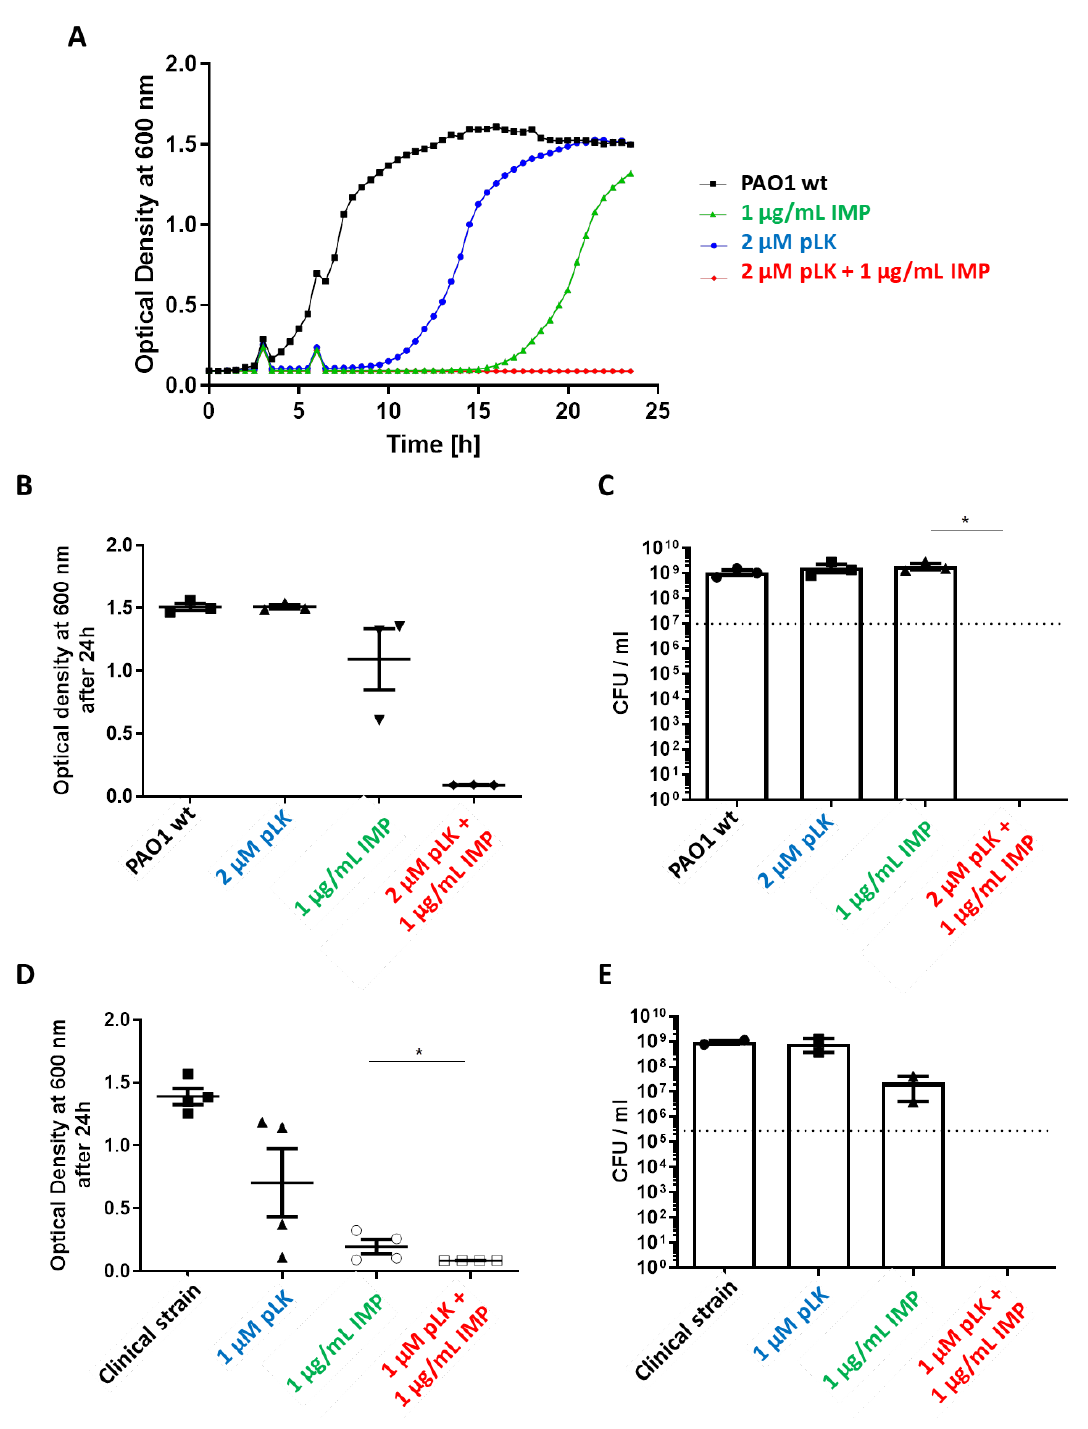
Figure 2. In vitro effect of the pLK and imipenem association against the reference (PAO1) and imipenem-sensitive P. aeruginosa strains. PAO1 (1 × 10 7 /mL in exponential phase) and an imipenem- sensitive clinical P. aeruginosa (1 × 10 5 /mL in exponential phase) strain were incubated at 37 ◦ C in Mueller–Hinton medium in the presence or absence of 2 uM ( A – C ) or 1 uM ( D , E ) poly-L-Lysine (pLK), 1 µ g/mL imipenem (IMP) or their combination. ( A , B , D ) Bacterial growth was measured by monitoring the optical density at 600 nm after 24 h of incubation. ( C , E ) Determination of the colony forming unit (CFU)/mL was evaluated after 24 h of incubation. Values are mean ± SEM of three independent experiments. Statistical analysis was performed using the Mann–Whitney test. * p <